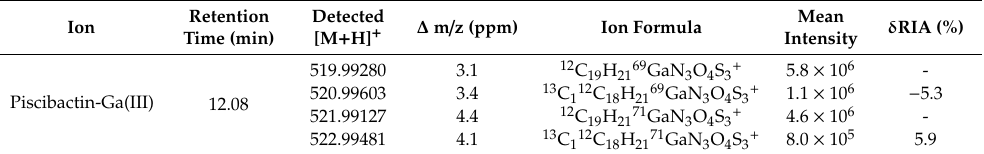
Figure 6. ( a ) LC-HRMS total ion chromatogram of the fraction containing piscibactin-Ga(III) complex eluted with H 2 O and CH 3 CN (1:1) from an OASIS ® HLB cartridge; ( b ) extracted ion chromatogram from m / z 519.7–520.4; ( c ) high resolution mass spectrum corresponding to the peak with t R = 12.06 min; ( d ) isotopic ion abundance from m / z 516.0–523.5, including M + 1 / M ( 13 C 1 / 12 C), calculated with Thermo Xcalibur software 3.0. LTQ-Orbitrap was operating at a resolving power of 30,000 (m / ∆ m) with a detection window setting around the compound of interest (between 350 and 600 dalton). Table3. ListofionsobservedinfractionelutedwithH 2 OandCH 3 CN(1:1) a , usingLC-ESI-LTQ-Orbitrap in Positive-ion Mode b